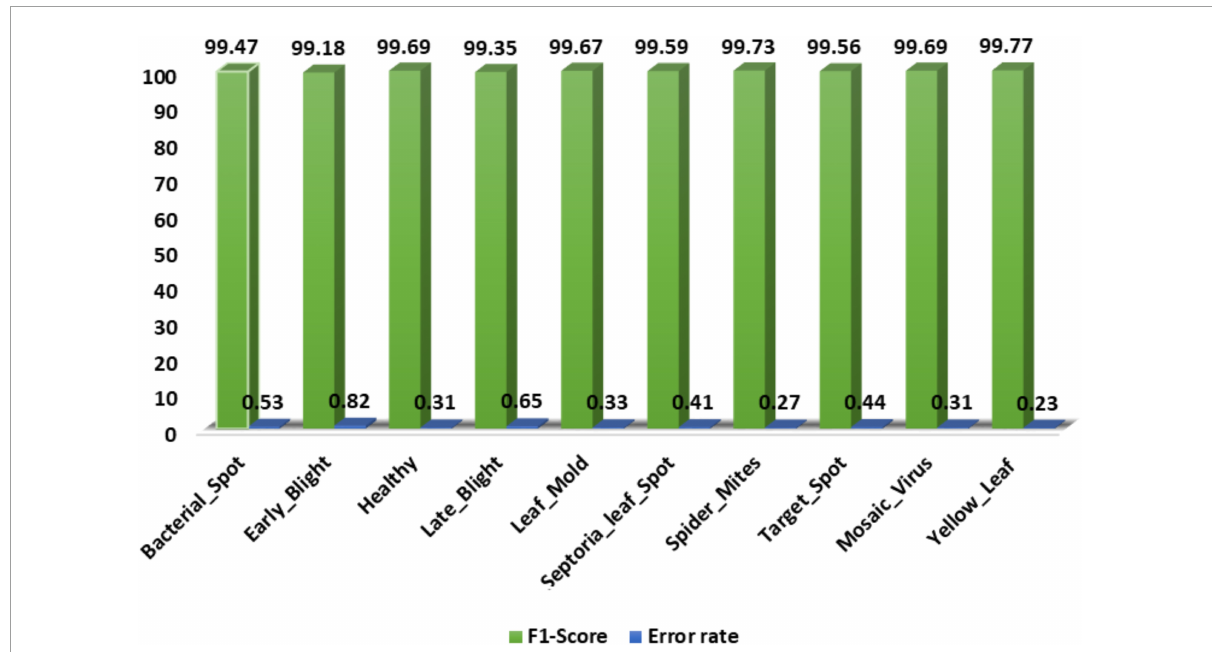
FIGURE10 A pictorial depiction of the class-wise F1-score values obtained for the DenseNet-77-based CornerNet model.